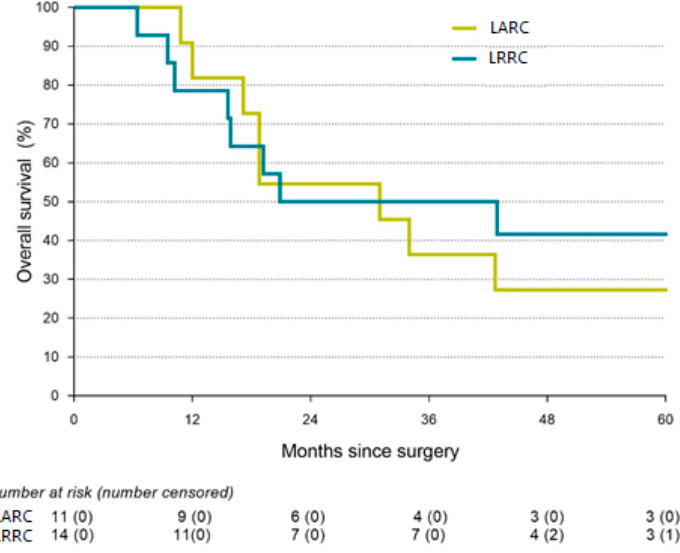
Figure 2. Kaplan-Meier graph of overall survival.